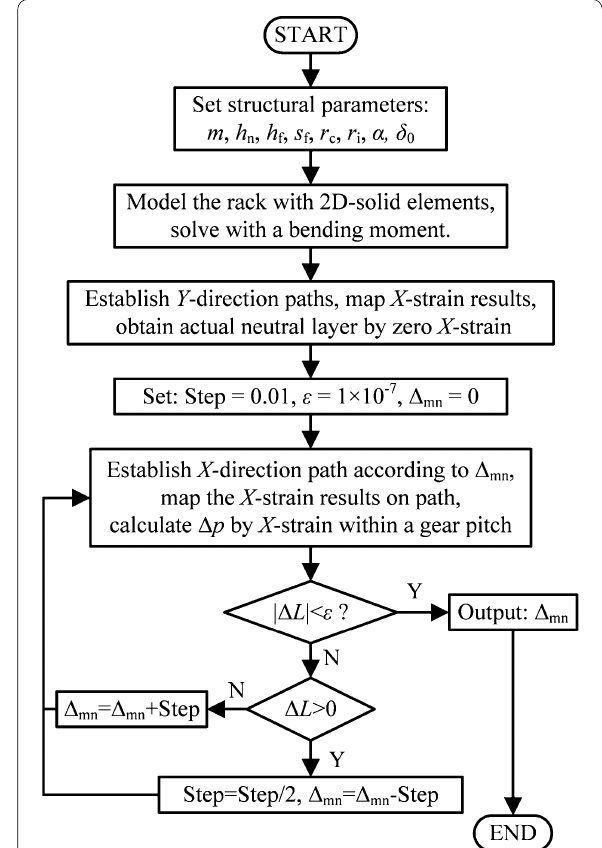
Figure 10 Flowchart for calculating neutral layer position and offset